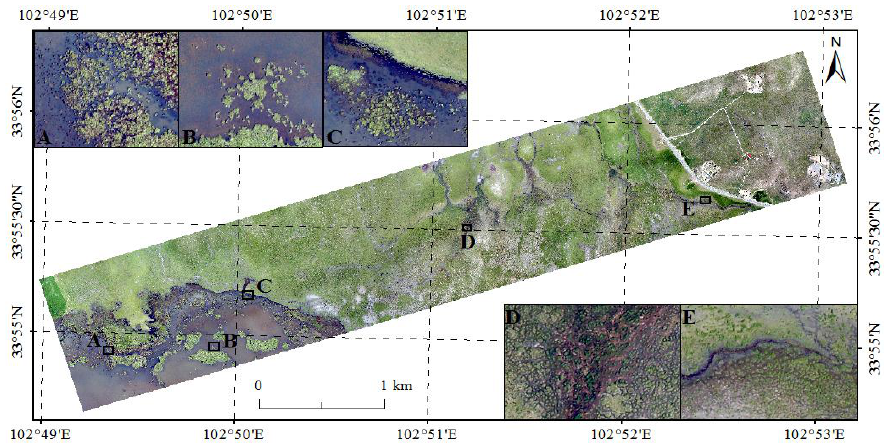
Figure 4. The UAV image of the transect in Zoige wetland, acquired in July 2014. A and B are the small patches of grass in the lake, C is the edge of lake, and D and E show the area with mixed water and grass.